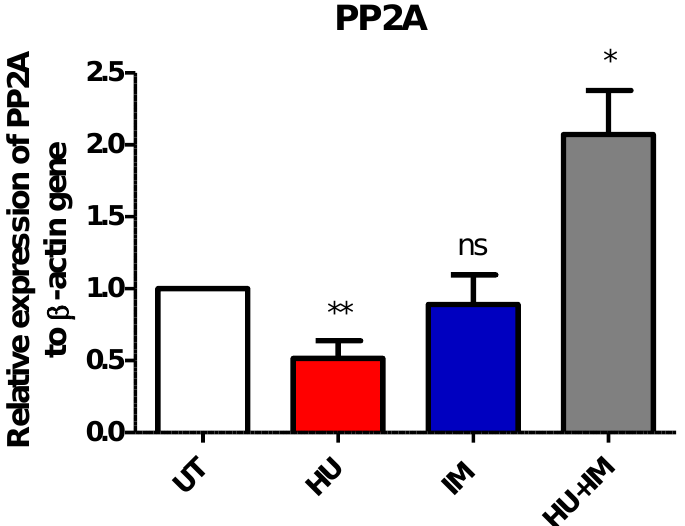
Figure 3. Relative expression of PP2A to β -actin gene. Two-tailed paired t -test showed a significant statistical difference between UT vs. HU (** p < 0.01), and UT vs. HU + IM (* p < 0.05). (mean ± SEM; n = 2).